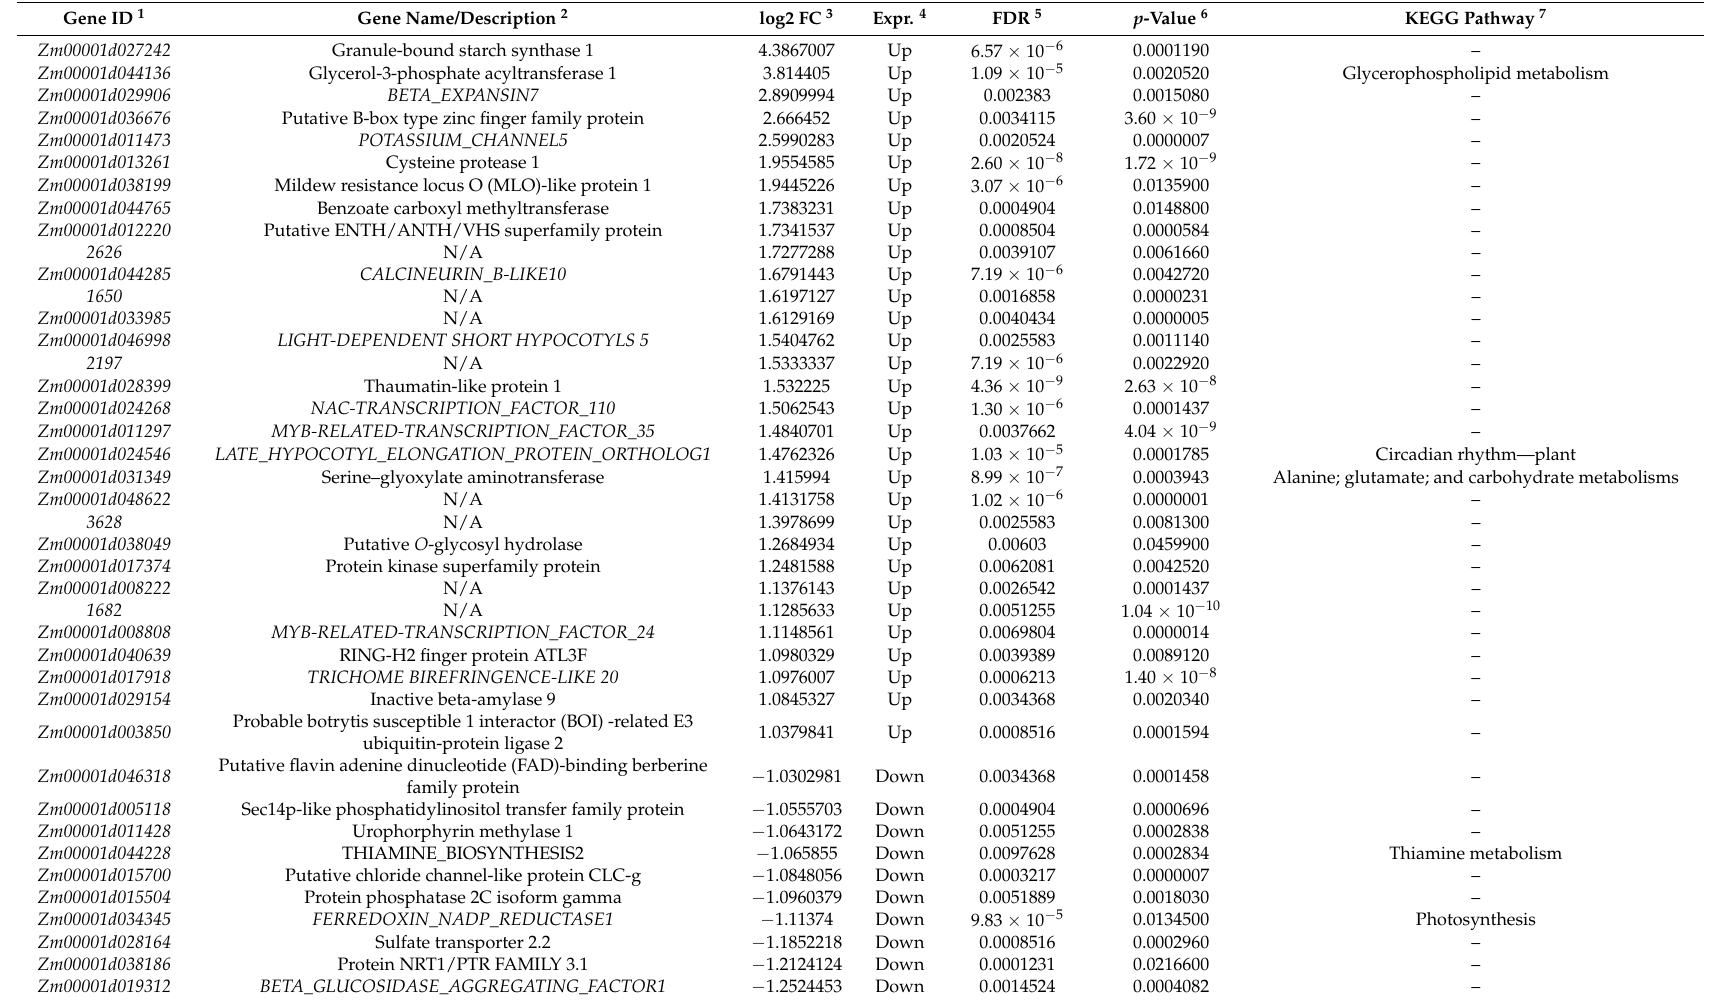
Table 4. Drought responsive differentially expressed genes (DEGs) specific to tolerant line